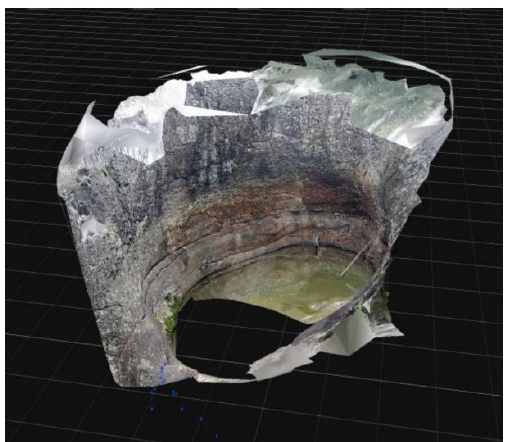
Figure 10. Reconstruction of “Las Moyas”, texture mesh. Disordered sequence videogrammetric method.